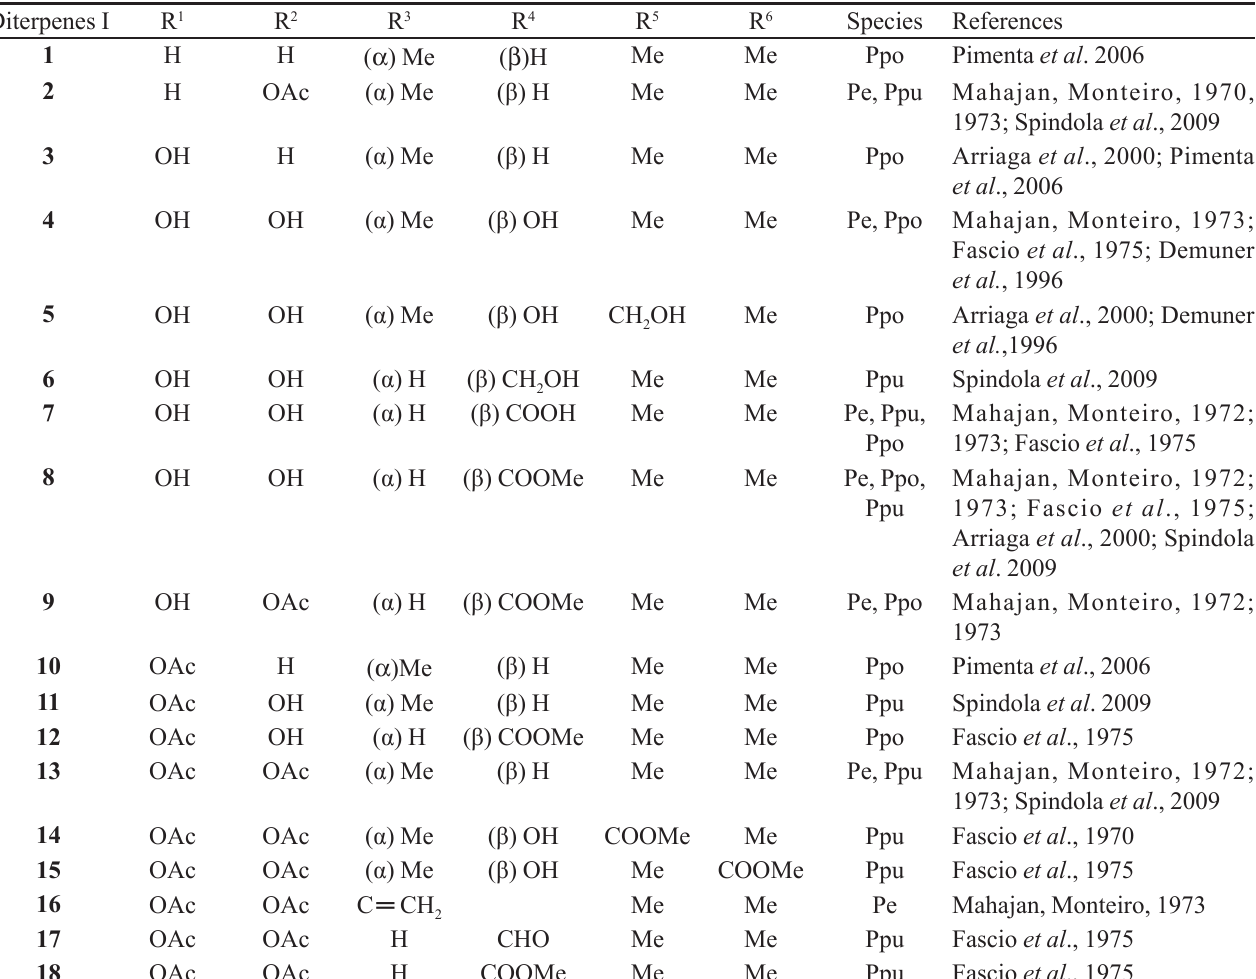
TABLE III - Structure of the diterpenes based on molecule I , identified from the Pterodon genus Diterpenes I